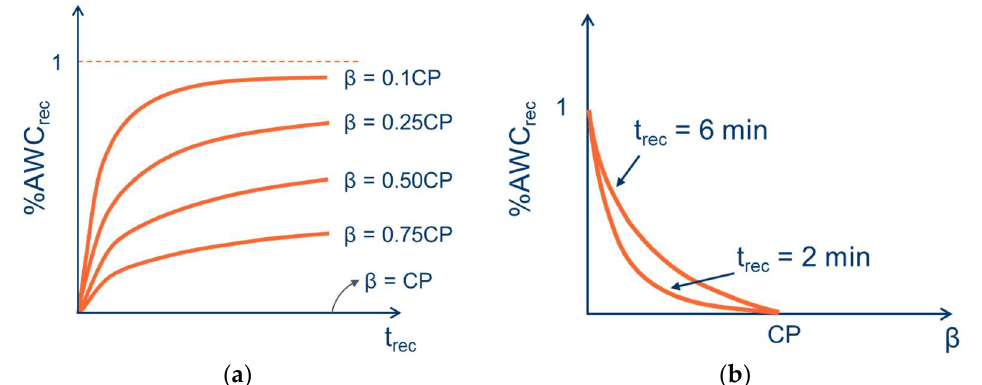
Figure 2. Hypothesized model of % AWC recovered as a function of recovery power (β) and t rec